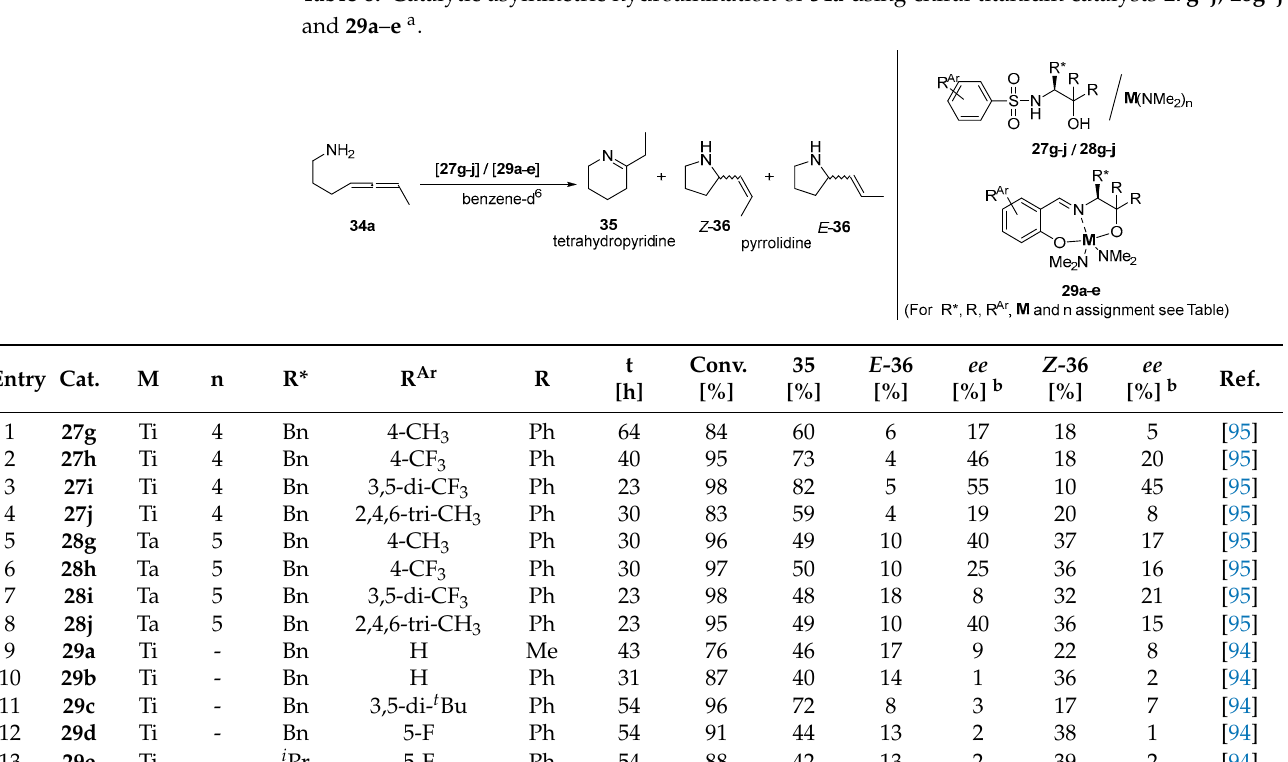
Table 8. Catalytic asymmetric hydroamination of 34a using chiral titanium catalysts 27g – j , 28g – j and 29a – e a .